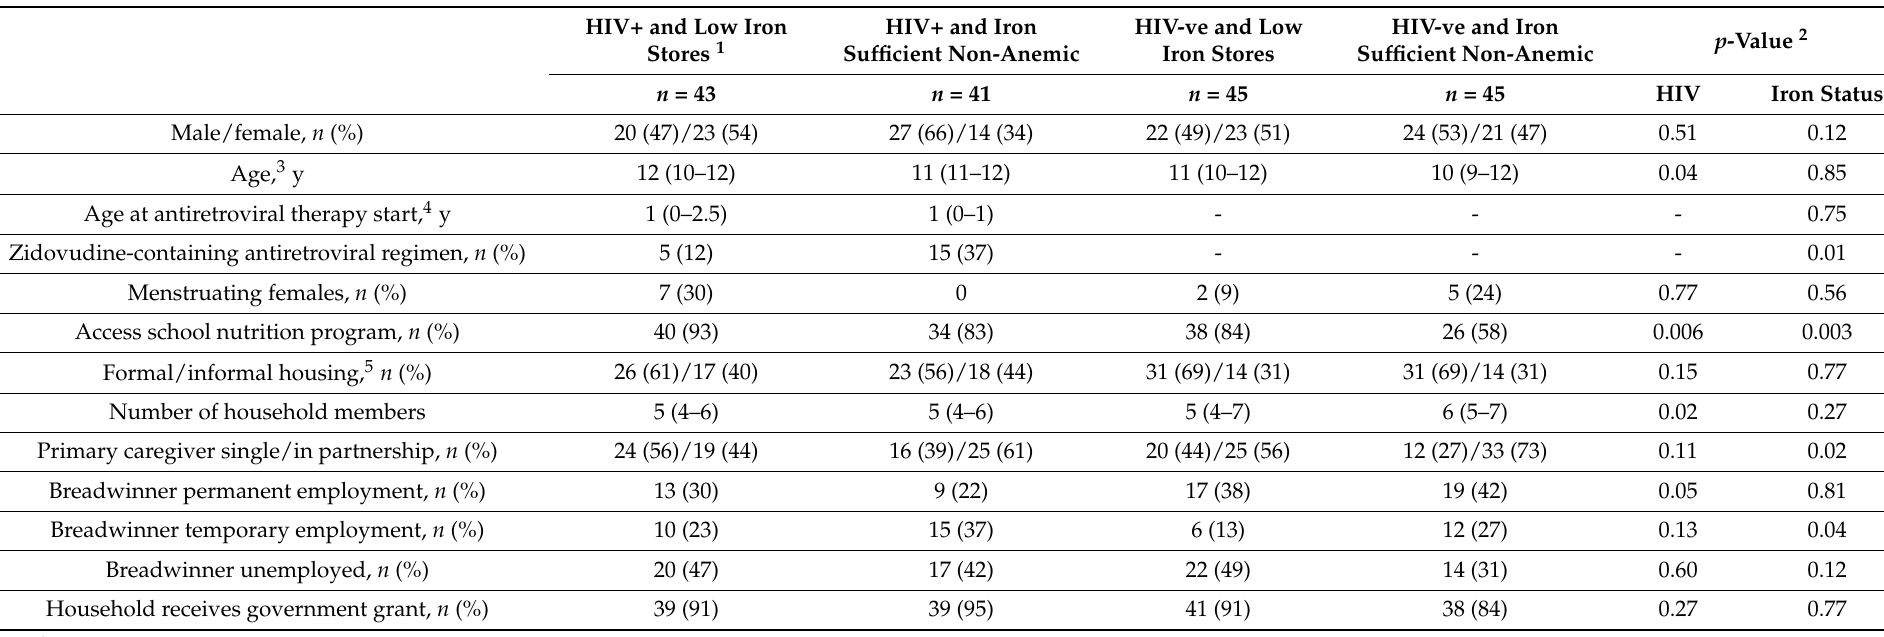
Table 1. Participant and household socio-demographic characteristics in the four groups of South African children purposefully selected according to human immunodeficiency virus (HIV) and iron